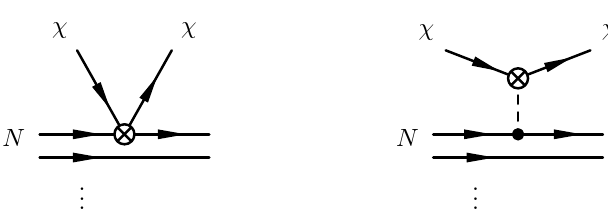
Figure 2: Leading-order diagrams for DM-nucleus scattering. The effective DM– nucleon and DM–pion interactions are denoted by a circle, the dashed lines denote mesons, and the dots represent the remaining nucleon